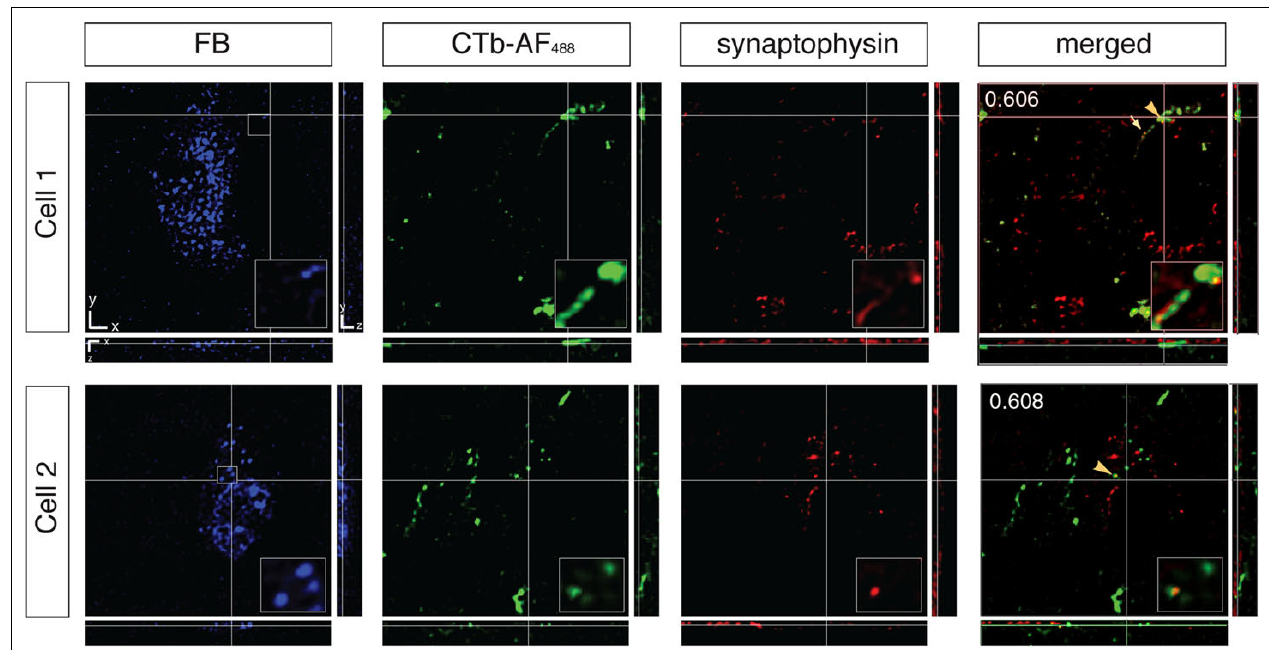
FIGURE 10 | Confocal micrographs of two area MT relay cells from layers K1 and K3 of the left hemisphere LGN associated with contralateral retinal input colocalized with synaptophysin. Blue images correspond to Fast Blue (FB)-labeled area MT relay cells, retinal input from the right eye labeled with CTb- AF and red images to synaptophysin. Right panels are merged images 488 + synaptophysin). Large and medium sized boutons are (FB + CTb-AF 488 colocalized (arrowheads) with synaptophysin proximal to FB-labeled cells. Cell 1 has a large bouton sending a fi ne axon (small arrow) to the cell body. From the